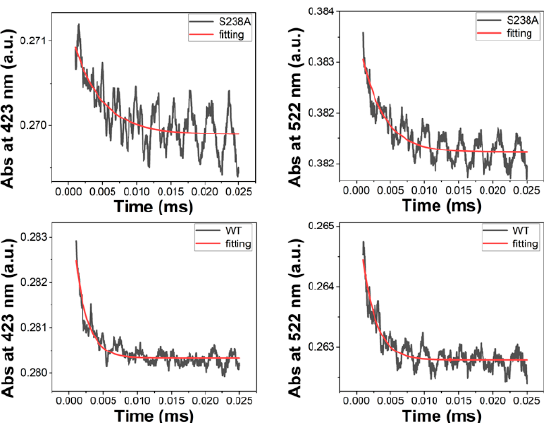
Figure 4. Stopped-flow absorbance changes (black) following transaldimination and homolysis in the S238A variant ( top panel ) and WT 5,6-LAM ( bottom panel ). Transaldimination ( left panel ) was monitored at 423 nm. Homolysis ( right panel ) was monitored at 522 nm. The rate constant was extracted with a fitted single-exponential decay function (red).